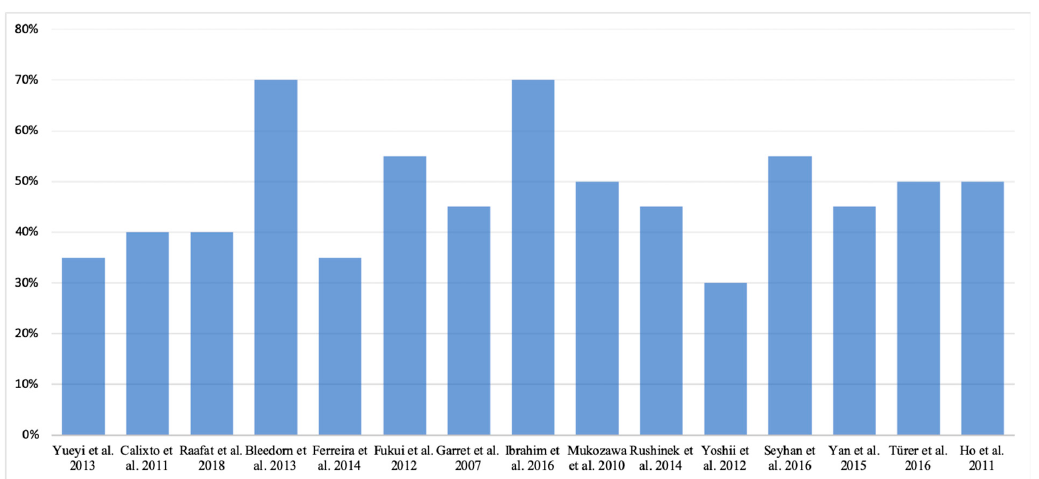
Figure 2. Quality assessment of the studies included according to the Animal Research: Reporting in vivo Experiments (ARRIVE) guidelines’ checklist.